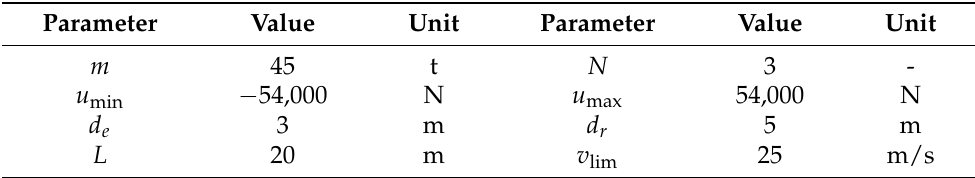
Table 1. Parameters using in the